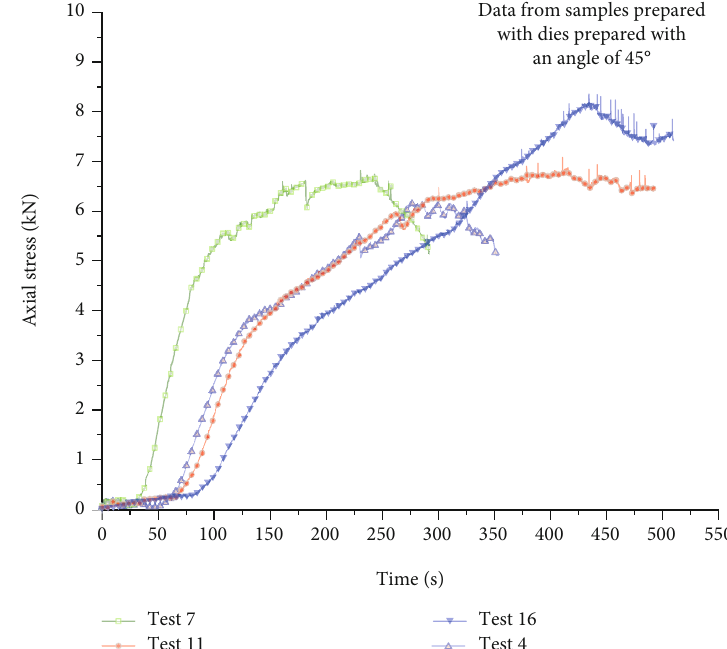
Figure 8: Shear stress-time curves.